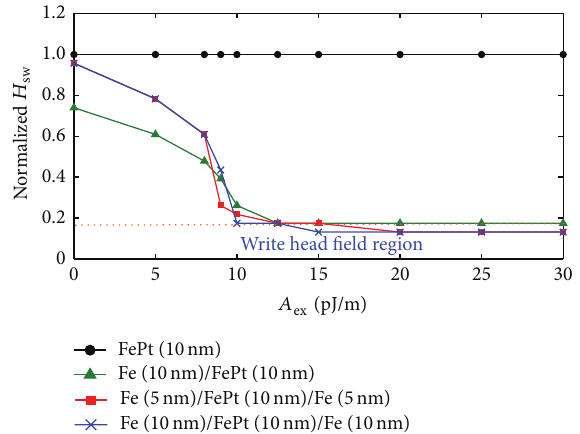
and 𝐴 ofsinglelayercontinuousmedia, sw ex